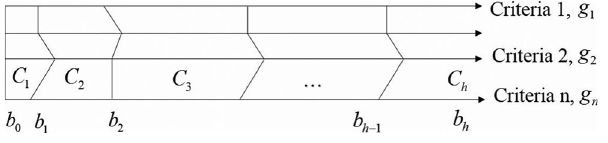
Fig. 3 Definition of categories using limit